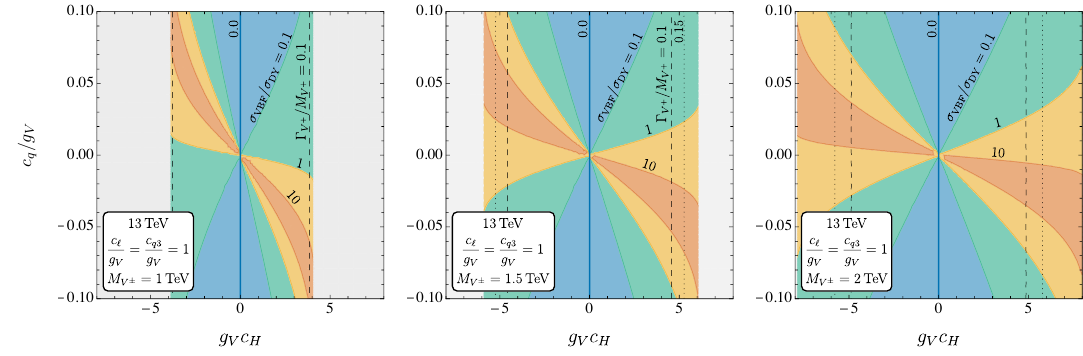
Figure 2 . The ratio of VBF to DY production cross-sections for charged resonances in the = 1 , 1 . 5 , and 2 TeV (left, centre g V c H − c q /g V parameter region for resonance masses of M V ± and right) at 13 TeV. In the blue and red regions the ratios become (cid:28) 1 and (cid:29) 1 , respectively. Theoretically disallowed regions in the simplified model are shown in light